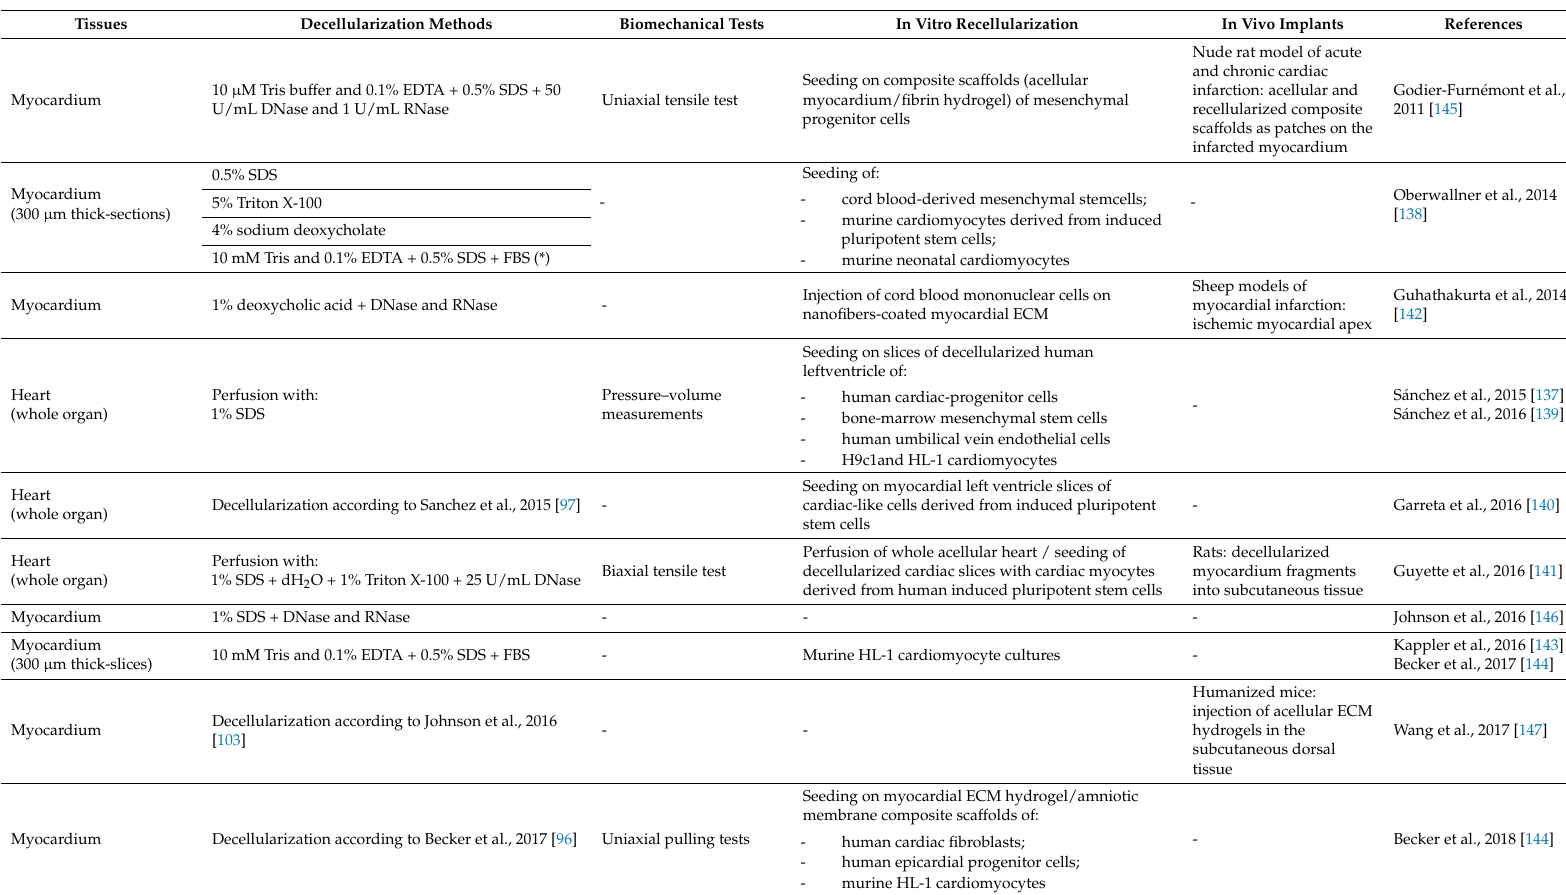
Table 4. Cardiac tissues. Decellularization techniques, biomechanical tests, recellularization methods, and in vivo implants of human heart extracellular